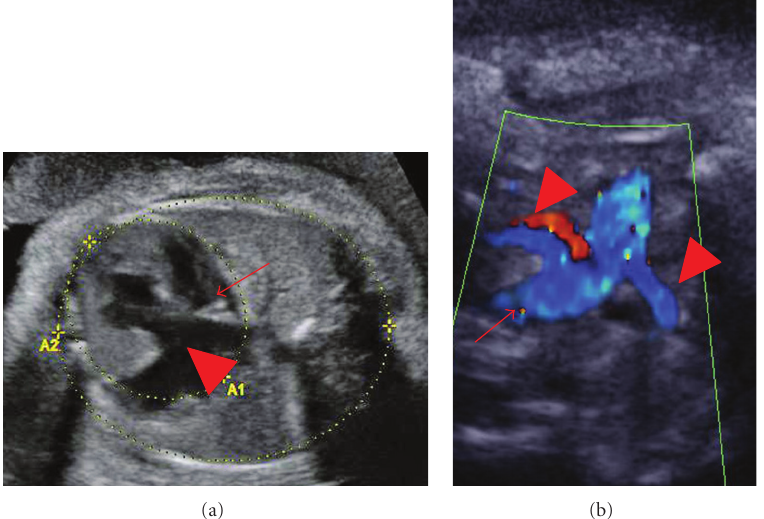
Figure 1: Color Doppler findings of fetal heart anomaly. (a) Ventricular septal defect (arrow): atrioventricularis communis (arrow head), (b) truncus arteriosus communis where the pulmonary artery branched from the common arterial trunk:truncus arteriosus communis (arrow), pulmonary artery (arrow